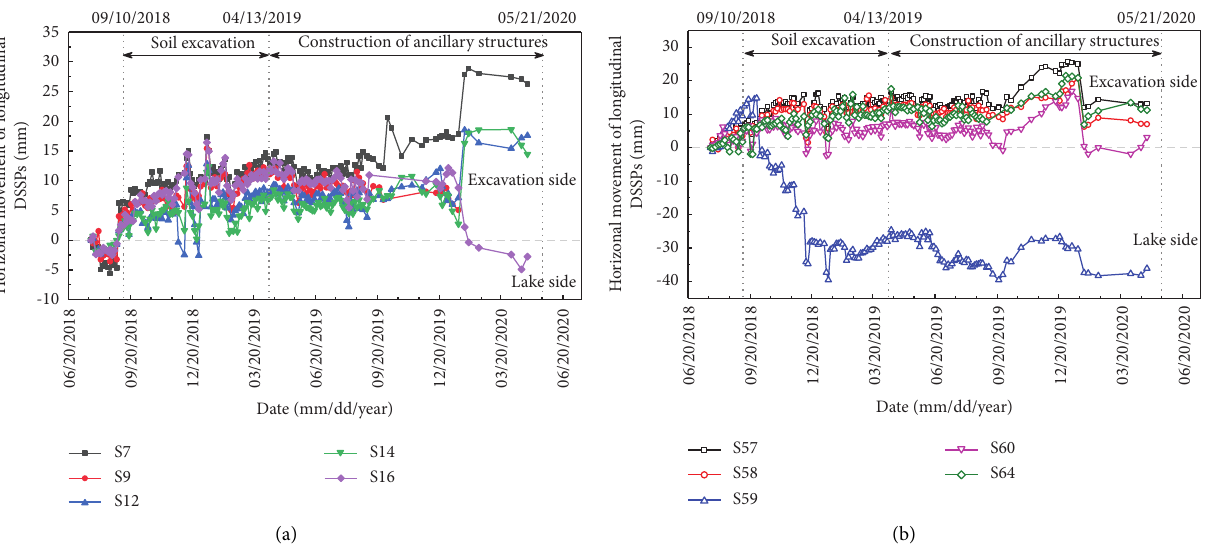
Figure 10: Development of the horizontal movements of the longitudinal DSSPs during construction. (a) On the north side of Zone #1 and (b) on the south side of Zone